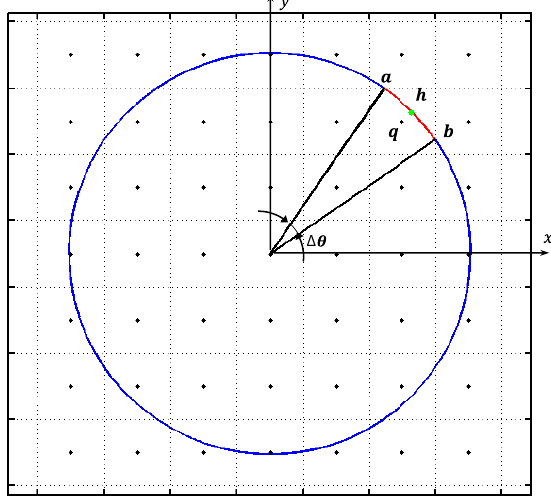
Figure 3. Schematic of a cross-sectional view of the actuator swept-surface in the computational